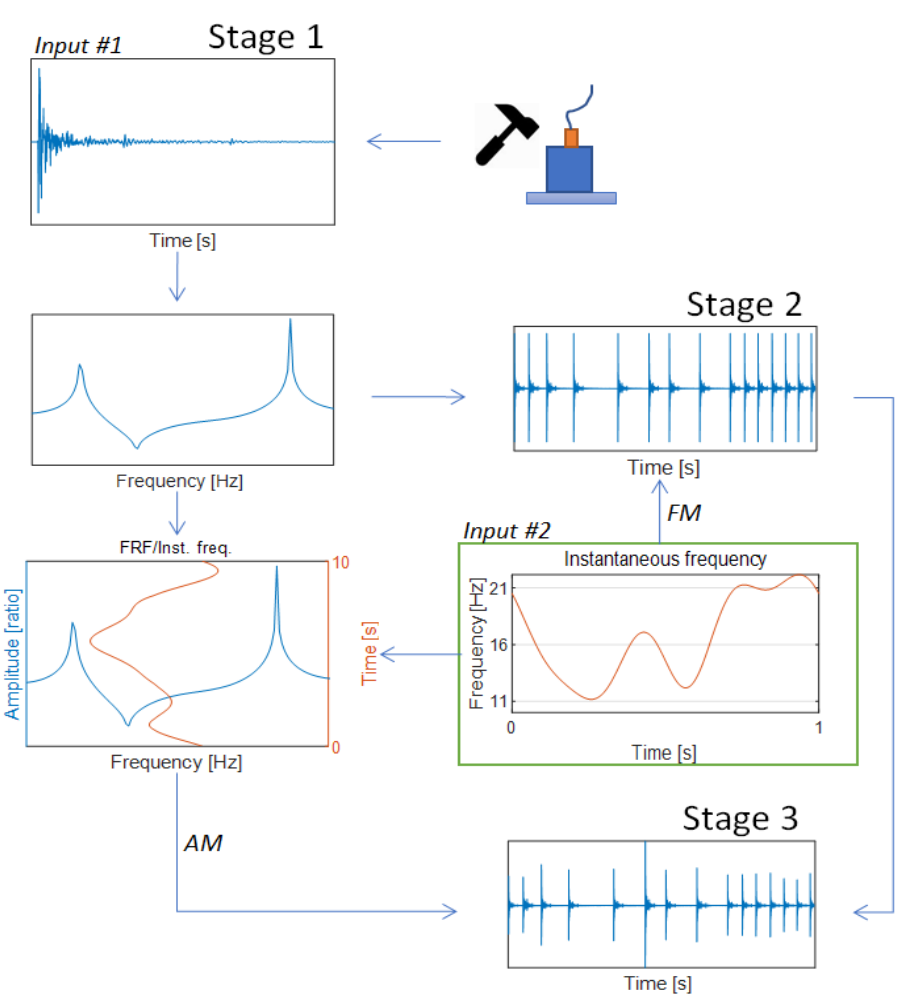
Figure 1. Methodology of generation of REB signal.